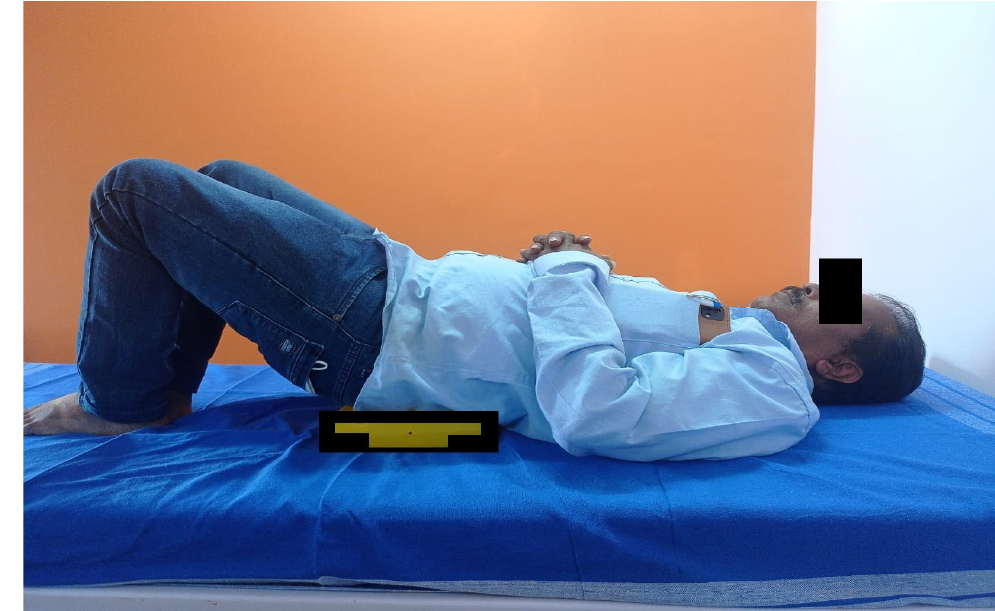
Figure 1. Patient performing pelvic clock exercises .